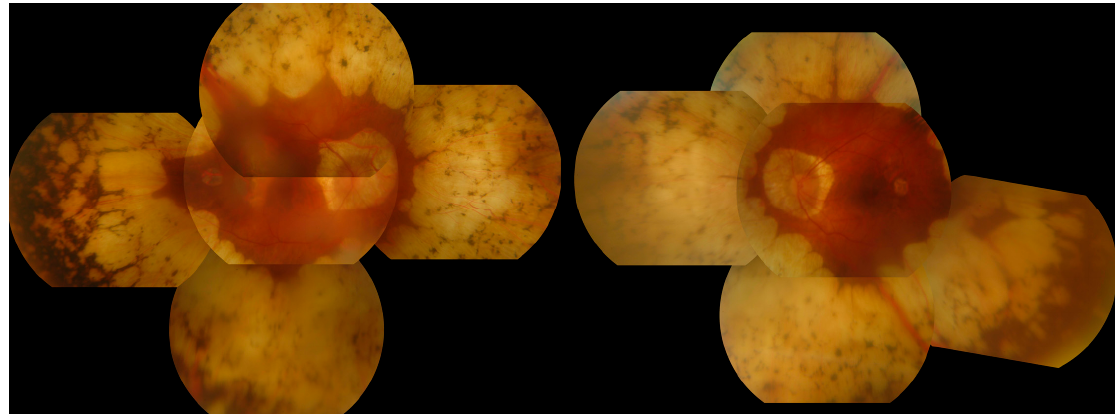
Figure 9. Montage of fundus photography of an affected gyrate atrophy (GA) patient with an OAT inversion. Note the marked retinal and choroidal atrophy affecting the mid ‐ peripheral fundus of each eye with relative sparing of the central macular area. The preserved macular areas show the scalloped edges which are characteristic of the condition.